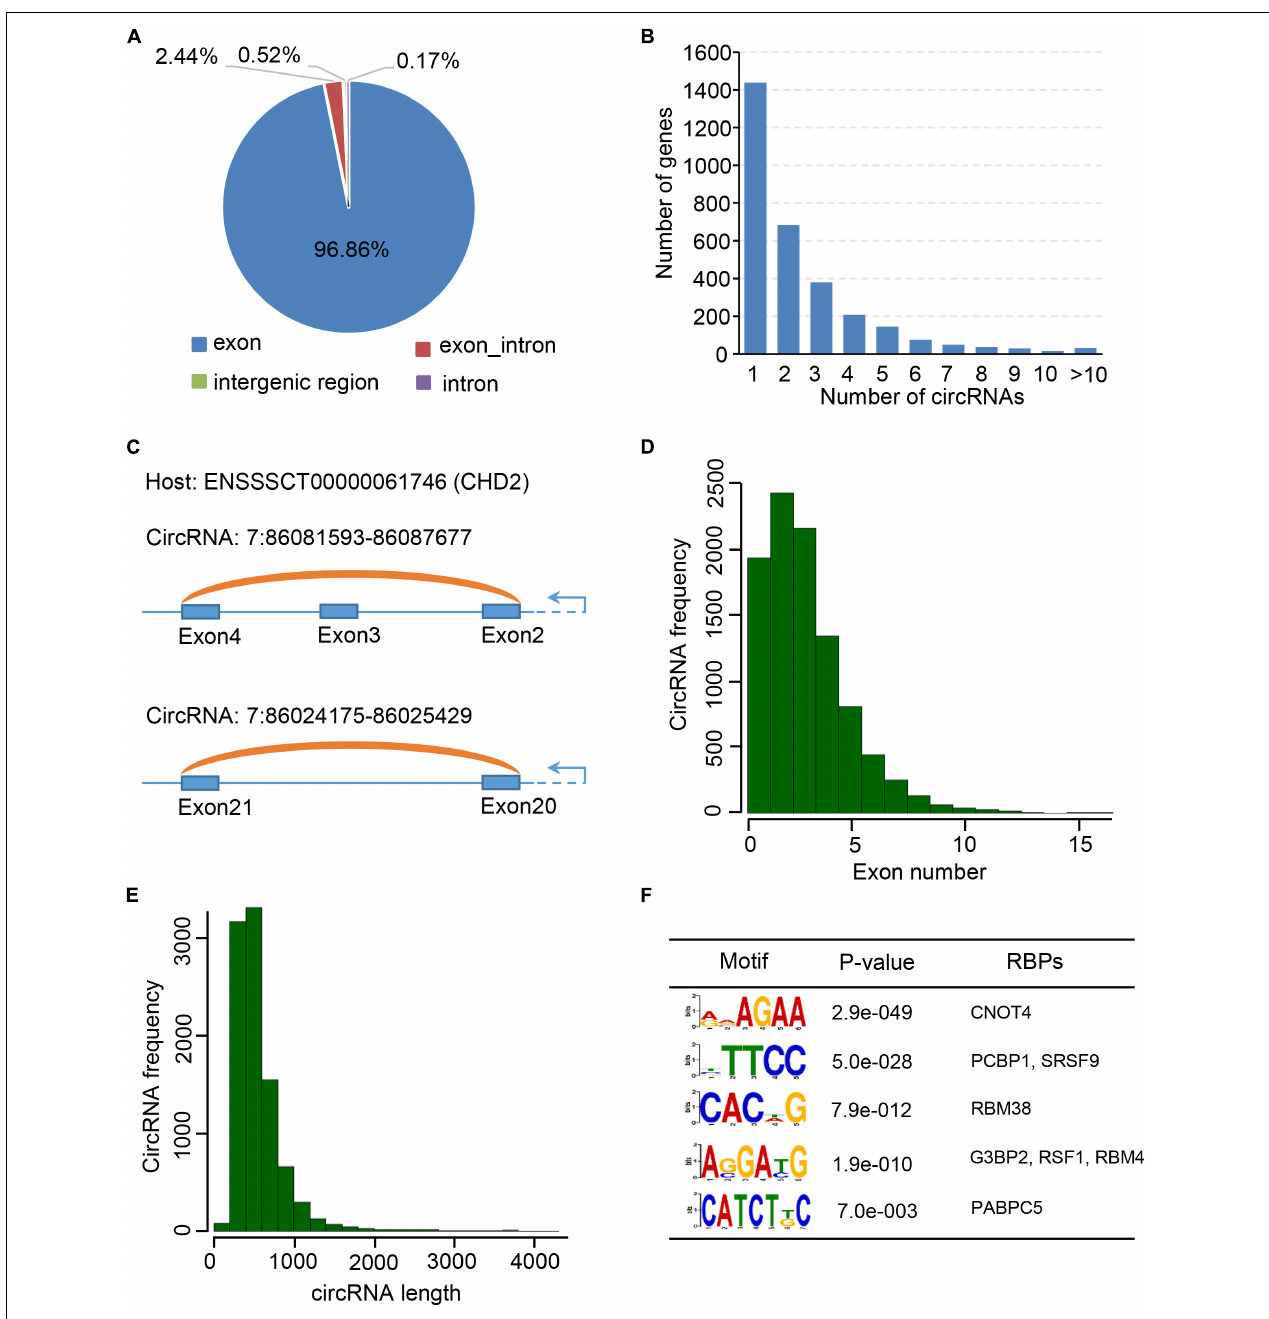
FIGURE 2 | Characterization of circular RNAs. (A) The pie chart shows the genic distribution of circRNAs. (B) The bar chart shows the correlation between gene number and the number of circRNAs. (C) CircRNA: 7:86081593-86087677 and circRNA: 7:86024175-86025429 transcribed from CHD2 gene. (D) Bar chart shows the exon number distribution of circRNAs. (E) Bar chart shows the length distribution of circRNAs. (F) RBP binding motif enriched in the flanking region of circRNAs.